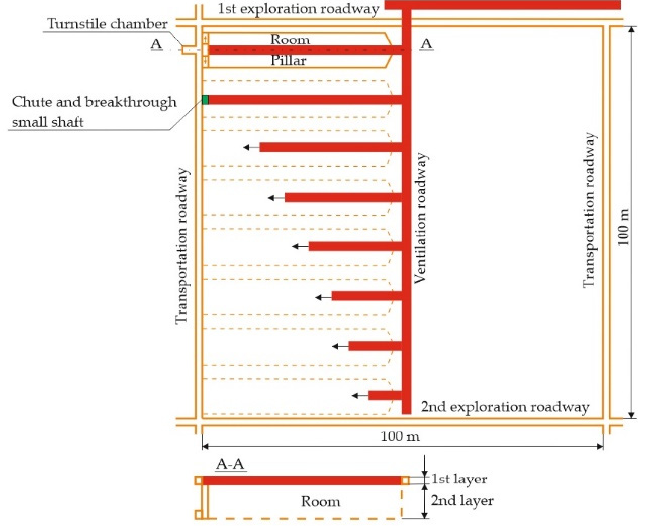
Figure 10. Scheme of preparation of a thick orebody for exploitation.